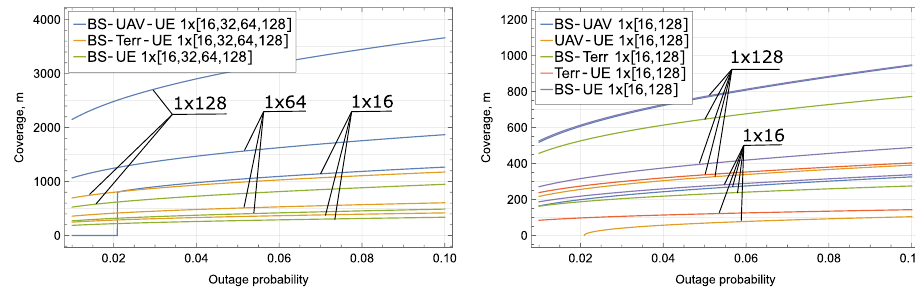
Figure 4. Coverage as a function of outage probability.